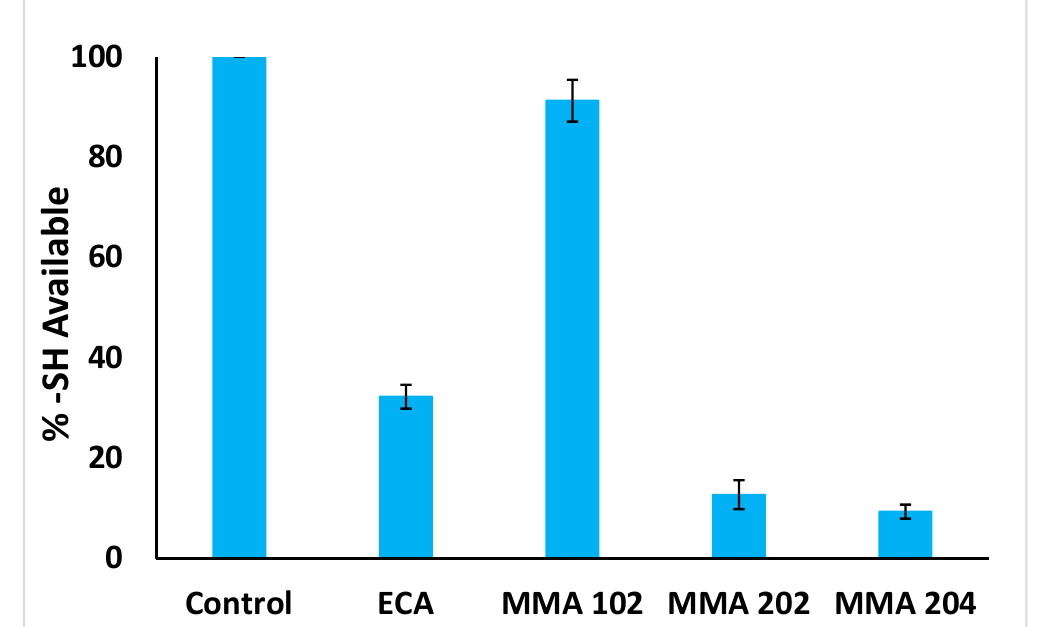
Figure 7. Percentage free SH available on Hb after 3h incubation with MMA compounds.